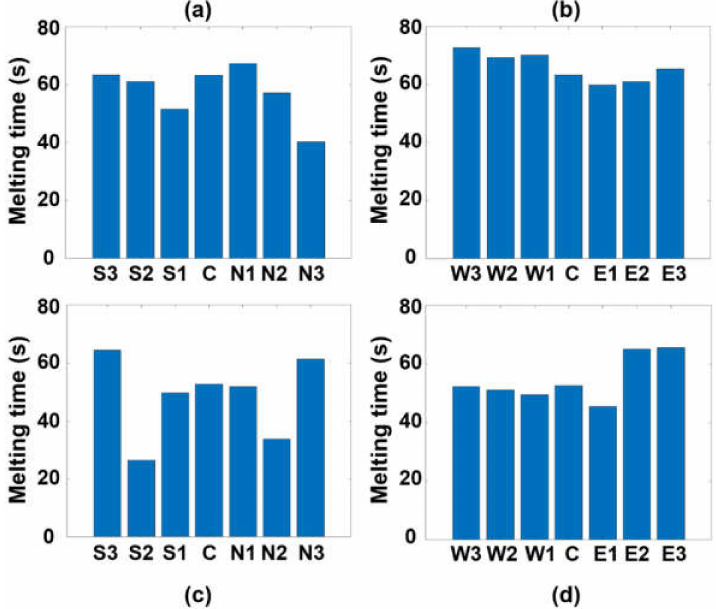
Figure 11. Melting times of the nickel particle. ( a ) Additions in the N–S axis at a level of 50 tons. ( b ) Additions in the E–W axis at a level of 50 tons. ( c ) Additions in the N–S axis at a level of 80 tons. ( d ) Additions in the E–W axis at a level of 80 tons. Steel superheat is 15